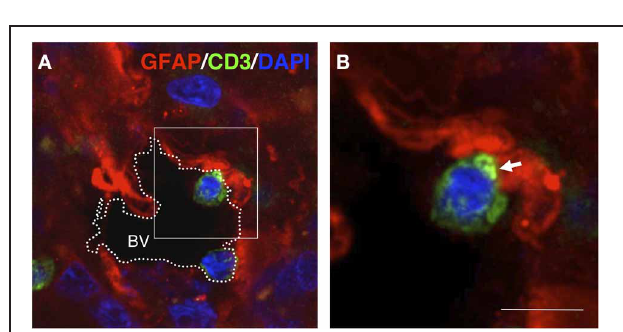
FIGURE 5 | T-cell–GFAP interactions in gliomas. Confocal section (0.5 μ m) obtained from a human glioma biopsy. Immunohistochemistry was performed with anti-GFAP antibodies (red), anti-CD3 antibodies (green) for T-cells and DAPI for counterstaining (blue). (A) Overview of a blood vessel (BV) in the tumor area in which two T-cells are contacting GFAP + cells at the edge of the vascular lumen. (B) High magnification of the frame indicated in (A) showing details of the T-cell–GFAP interaction. Importantly, the apposed T-cell displays clustered CD3 at the interface of the intercellular contact (arrow) [original findings can be found in Barcia et al. (2009)]. Scale bar: 15 μ